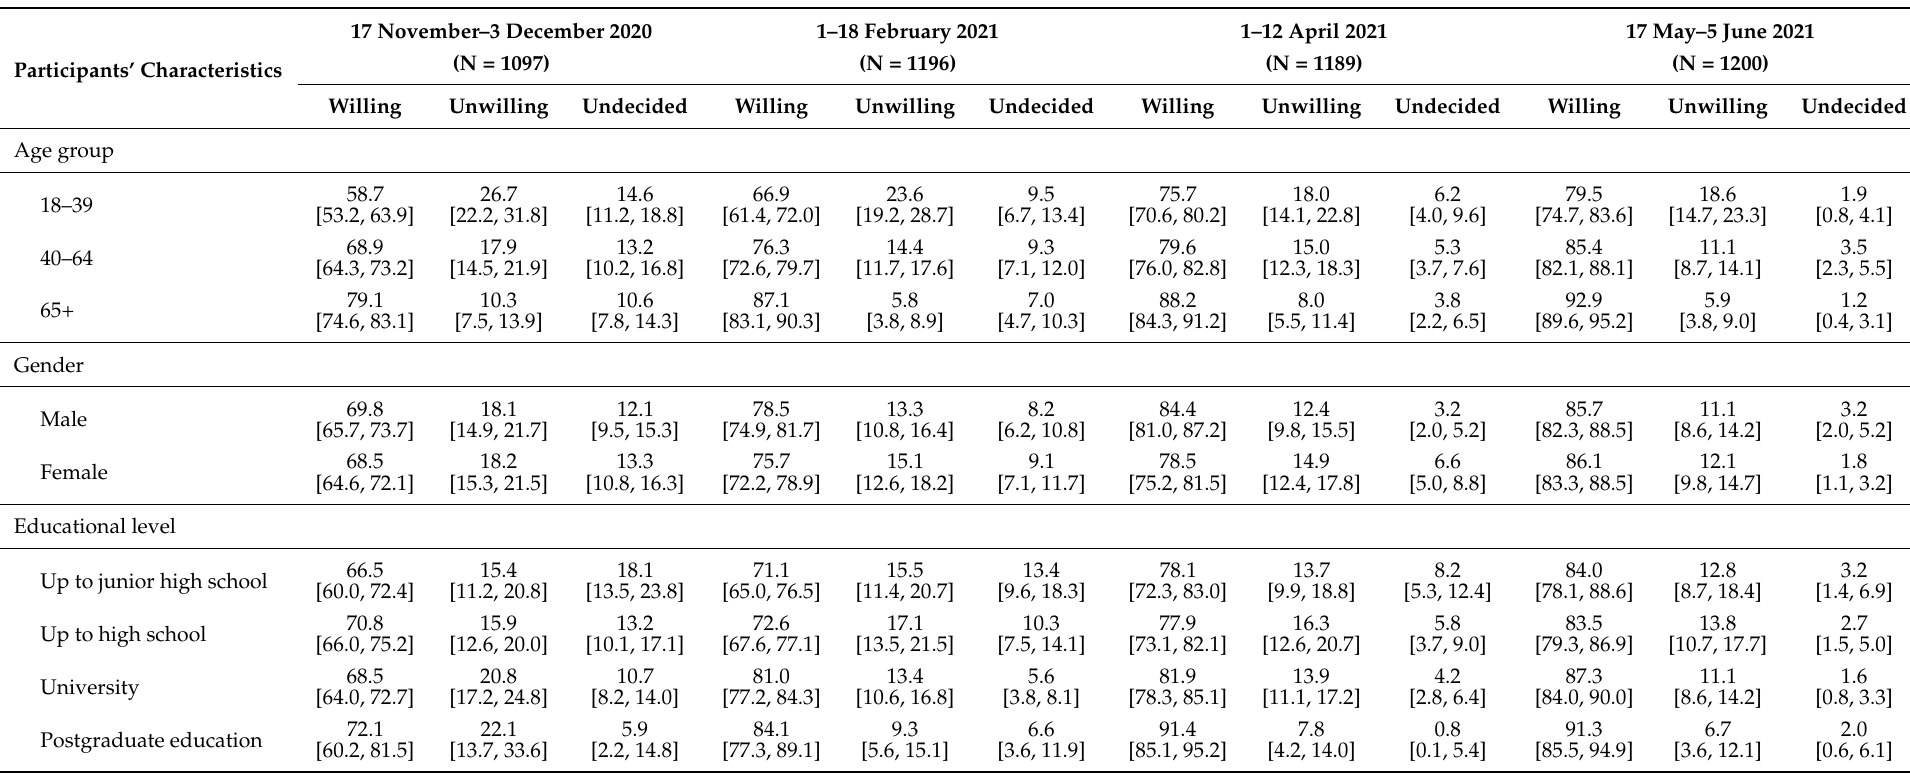
Table 2. Vaccination intention (% [95% confidence interval]) over time by respondents’ characteristics (Willing: “Probably/Definitely yes” or “Already vaccinated”, Unwilling: “Probably/Definitely not”, Undecided: “Don’t